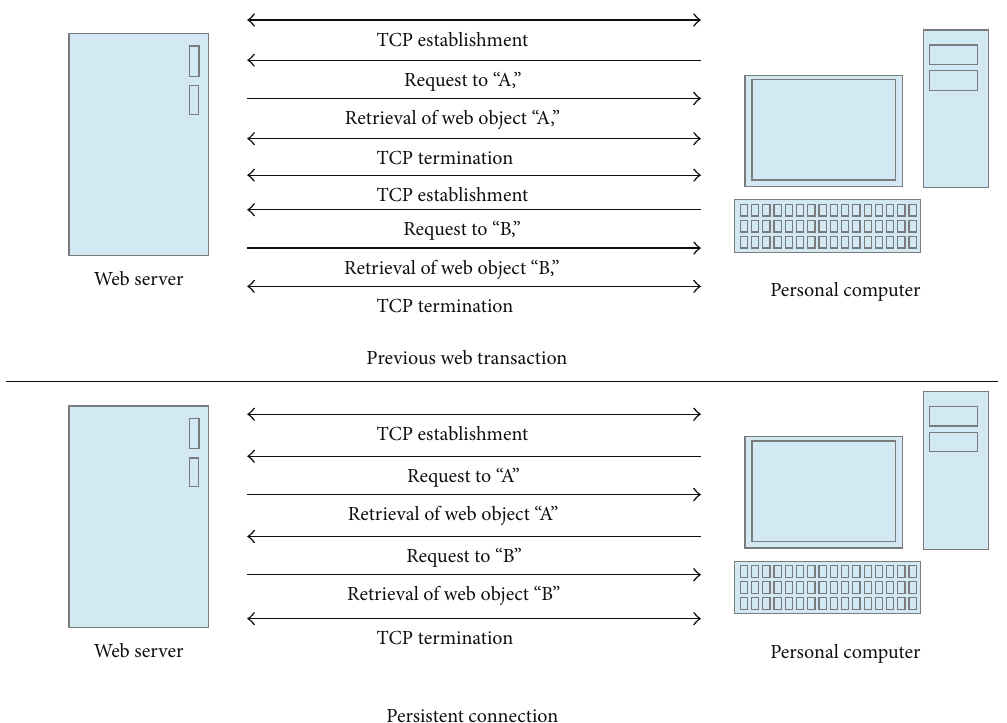
Figure 2: Retrieval of web document by the single connection.